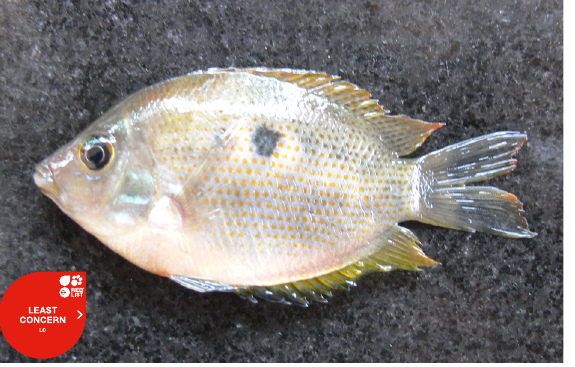
Image 17. Pseudetroplus maculatus